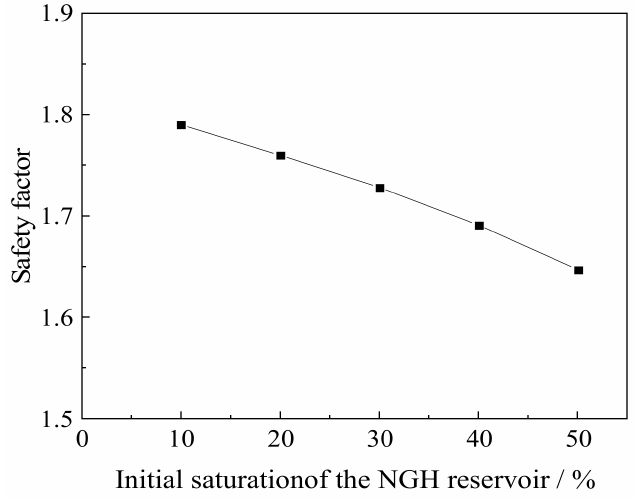
Figure 12. Safety factors corresponding to various initial saturations of the